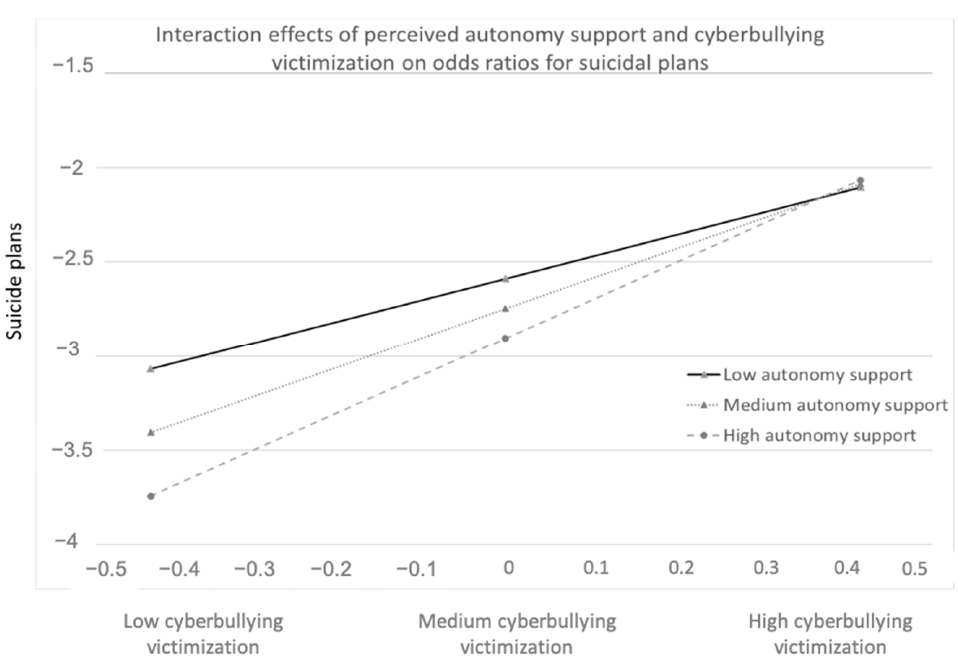
Int. J. Environ. Res. Public Health 2021 , 18 , 2867 Figure A2. Interactions between autonomy support, cyberbullying victimization, and suicide plans.